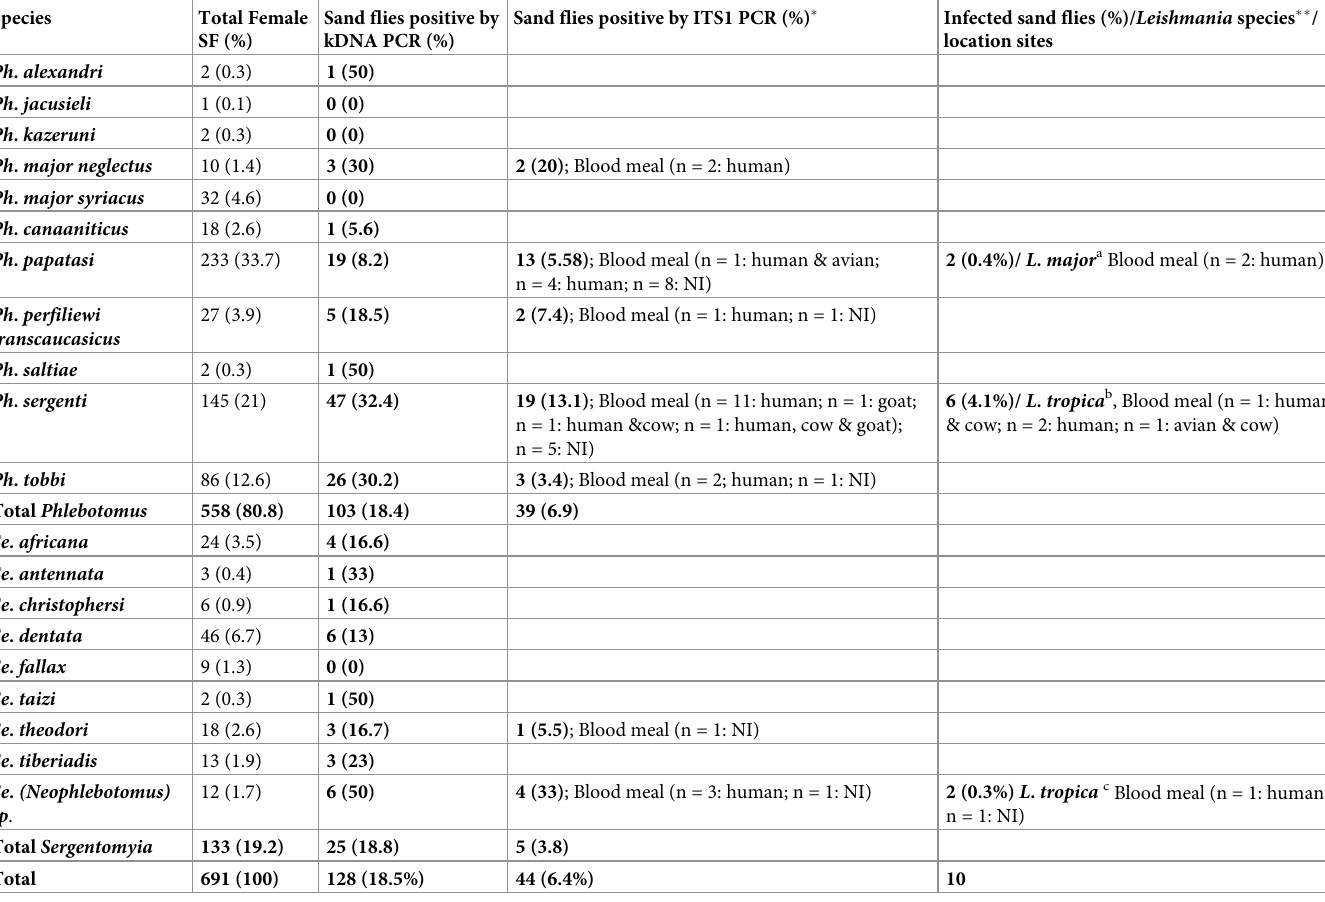
Table 1. The number of sand flies collected, their species diversity, relative abundance, infection rates and positivity rate for the presence of different species of Leishmania